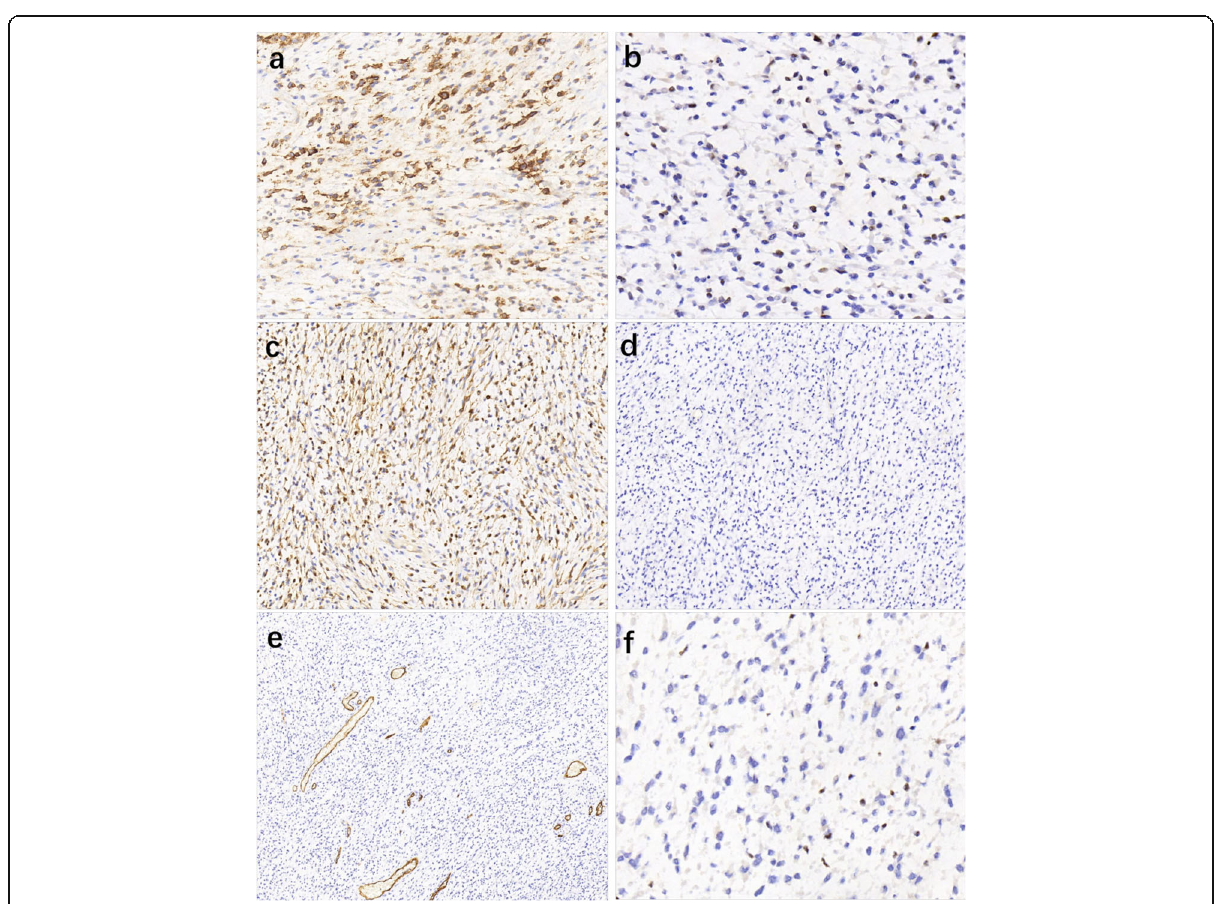
Fig. 2 Immunohistochemical findings most tumor cells were partially and moderate positive for EMA ( a ), and mild to moderate positive for ER ( b ). Calponin was expressed both in the cytoplasm and in the nucleus of the tumor cells. ( c ). The tumor cells were completely negative for S- 100(d) and CD34 ( e ). All tumor cells showed no INI1/SMARCB1 expression, while non-neoplastic endothelial cells expressed INI1/SMARCB1 ( f